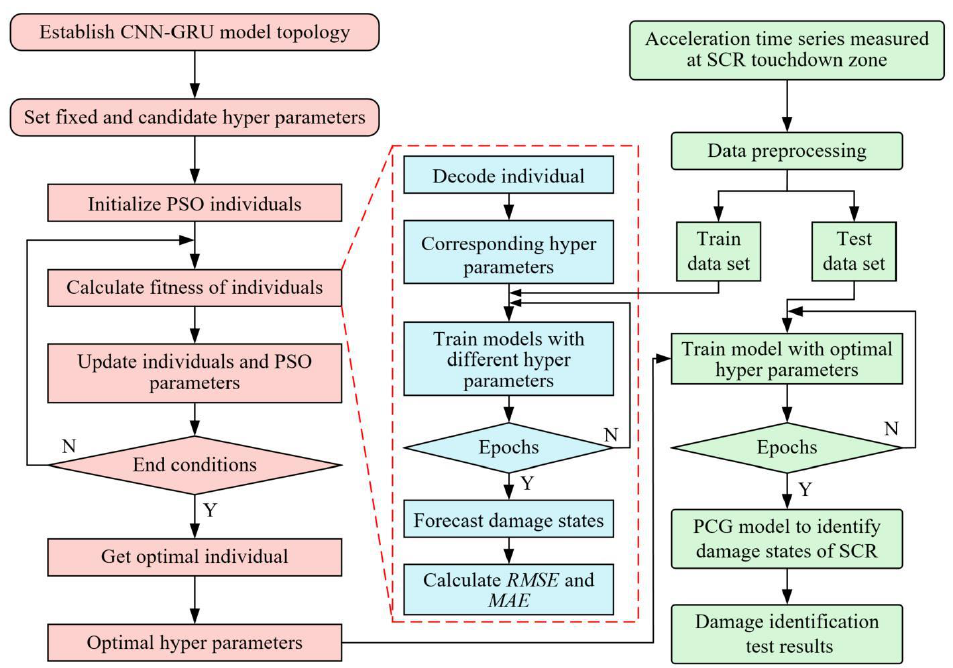
Figure 8. SCR damage identification method based on the PCG model.